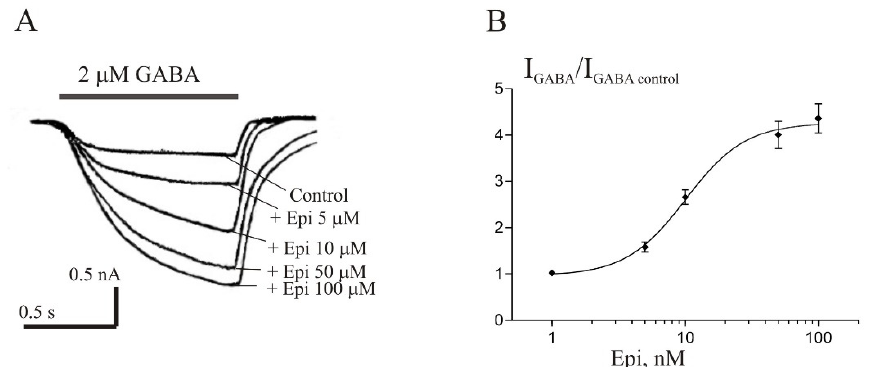
Figure 5. Epi potentiates the I GABA in pyramidal neurons of rat hippocampus. ( A ) Representative traces of the current induced by 2 µM GABA in control and during co-application with different concentrations of Epi. ( B ) Concentration dependence of Epi effect on the normalized peak amplitude of I GABA . Data points represent average from six cells.